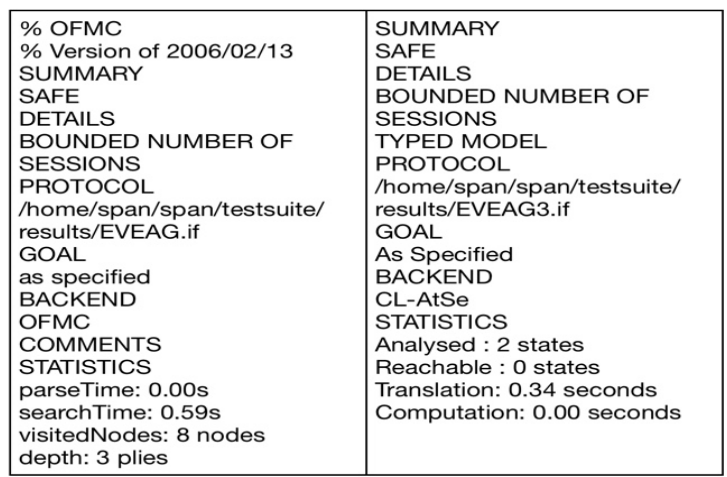
Figure 12. Mutual Authentication: AVISPA simulation results.